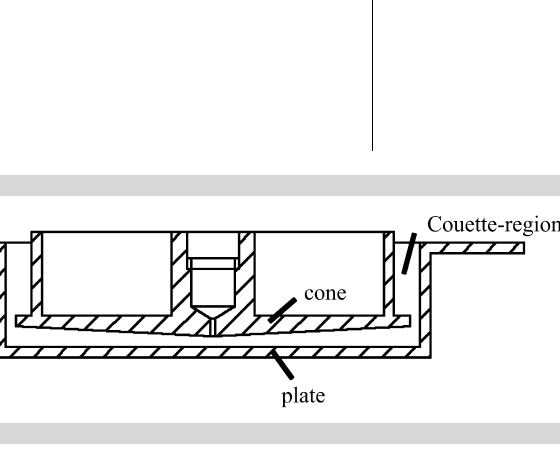
Figure 1: Schematic sketch of the shear